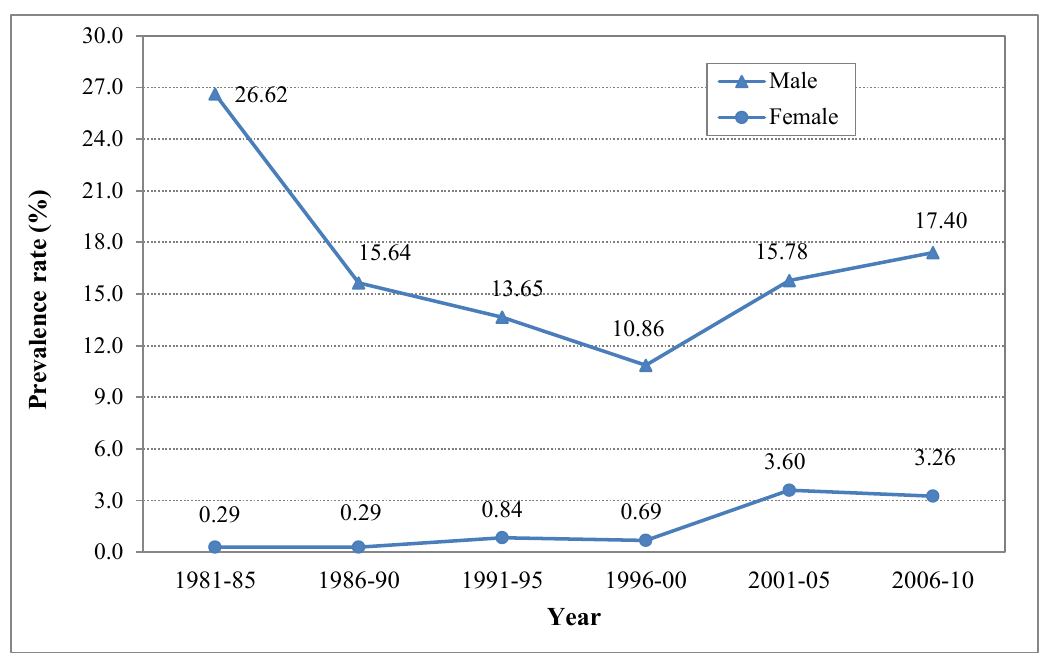
Figure 3. Estimated prevalence rate (%) of current smoking among adolescents in China, male and female,